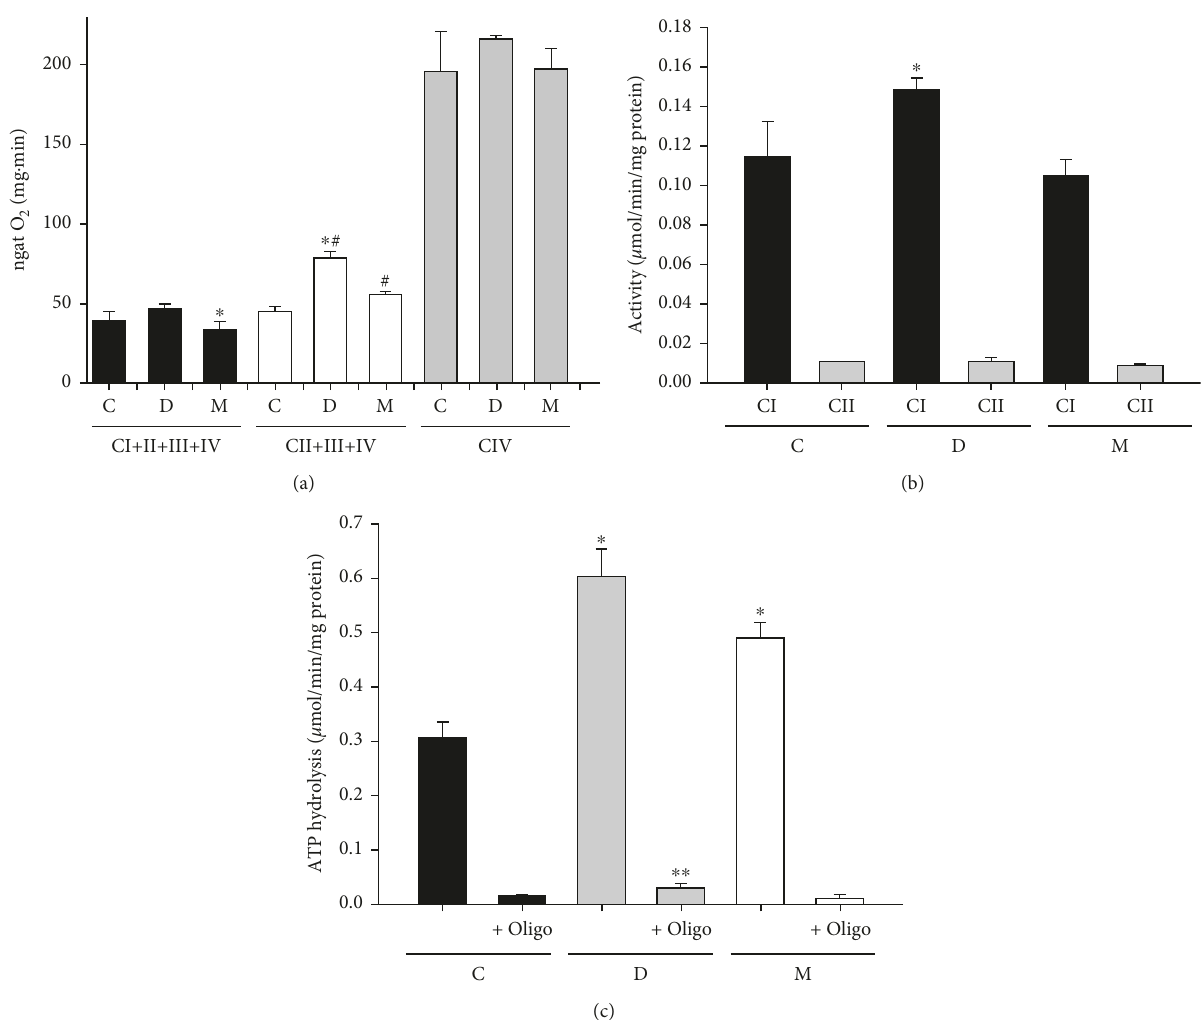
Figure 1: Moringa oleifera effect on mitochondrial respiratory chain. (a) Oxygen consumption